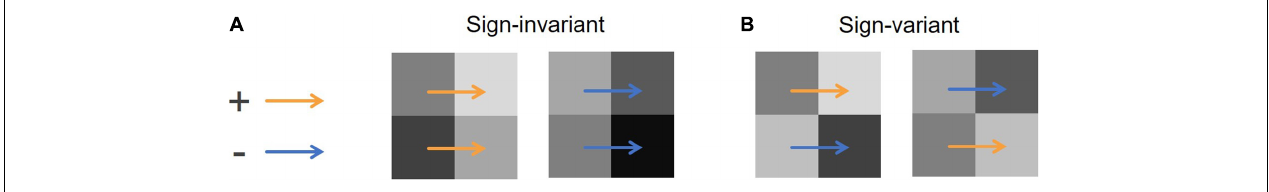
FIGURE 1 | Examples of X-junctions. Each set of four squares represents an X-junction composed of four pixels. The orange arrows indicate an increasing edge, where a pixel at the arrowhead is brighter than that at the arrow’s root. The blue arrows indicate a decreasing edge, where a pixel at the arrowhead is darker. (A) Examples of sign-invariant edges in an X-junction. Two vertical colinear luminance edges (those between two horizontally aligned pixels) are both increasing (left) or decreasing (right). (B) Examples of sign-variant edges in an X-junction. Two vertical colinear luminance edges show inconsistent contrast polarities.